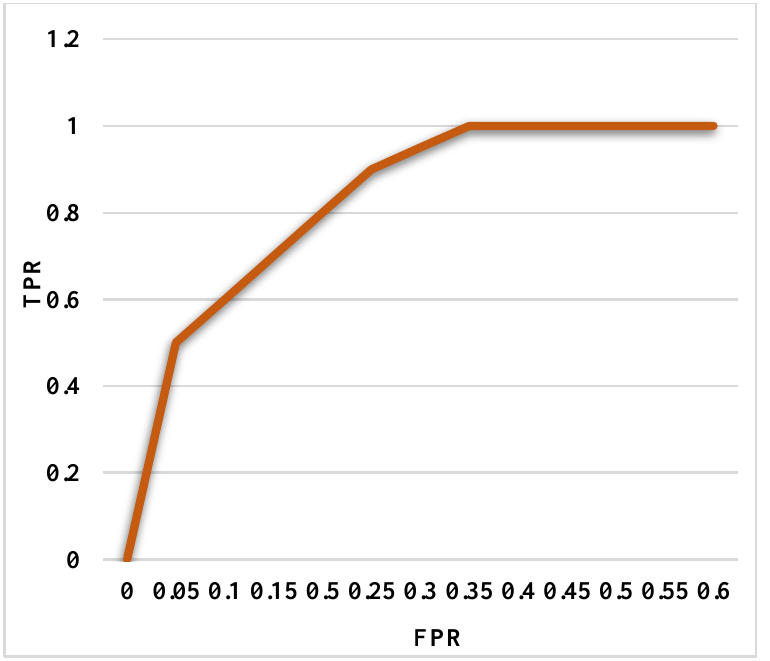
Figure 8. ROC analysis for the NSL-KDD dataset.